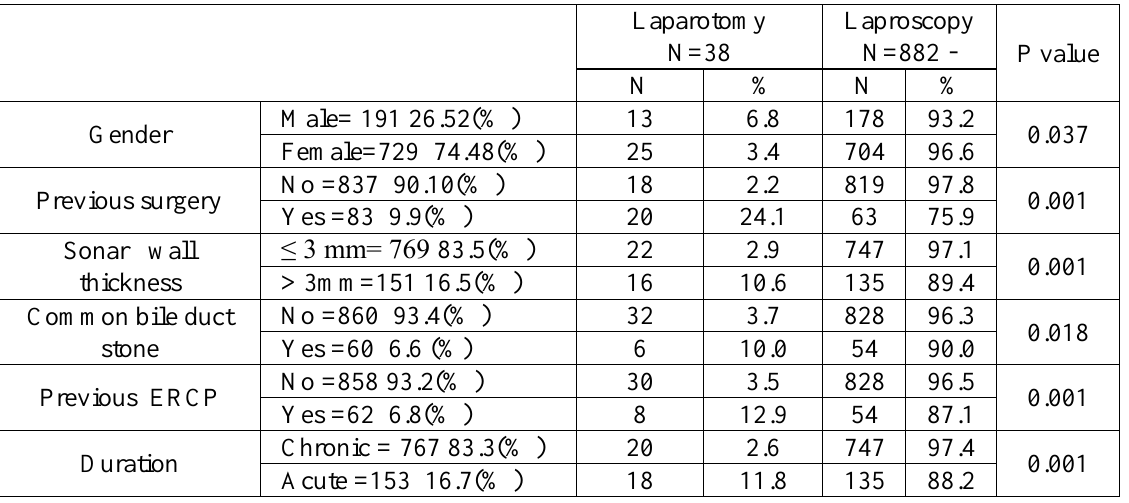
Table 2: Association between type of cholecystectomy and different